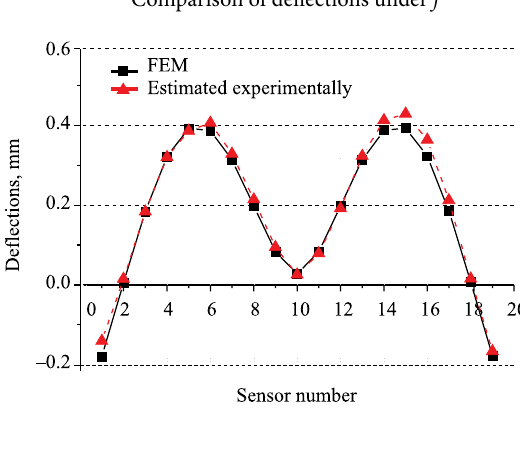
Fig. 9. Comparison of deflections under PBILs before